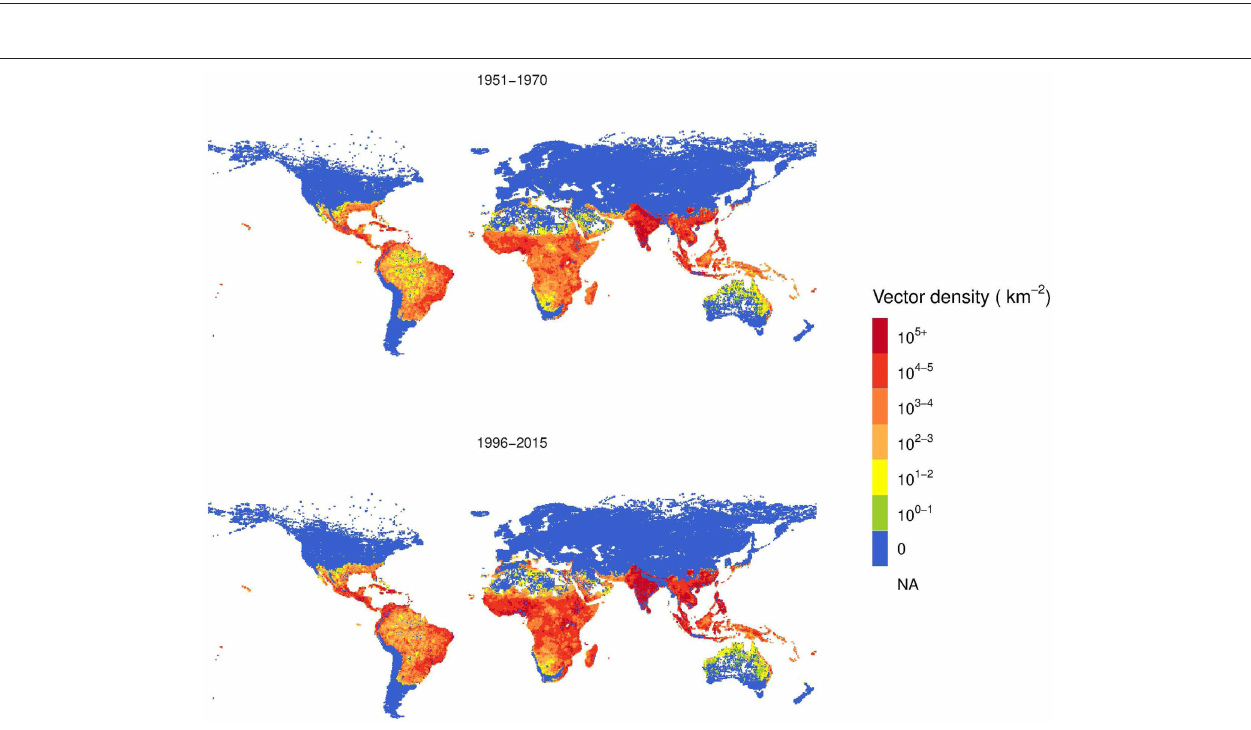
FIGURE 6 | Comparison two-decades averaged global distribution of female Aedes aegypti vector density over 45 years using Model B.